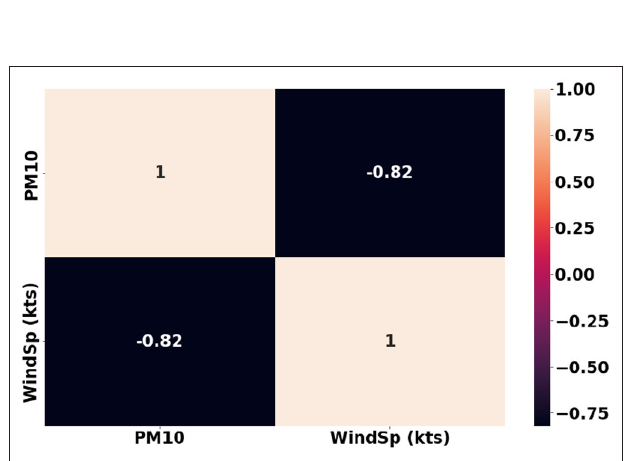
FIGURE 8 | Correlation between Wind Speed and PM 10